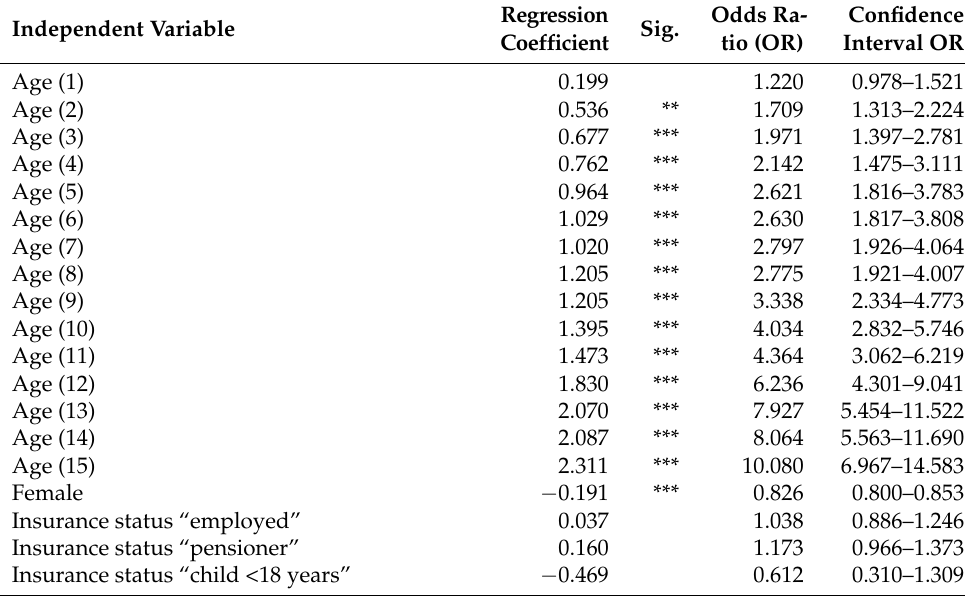
Table A1. Regression coefficients of the independent variables in the logistic regression models for predicting ACSH in the full list